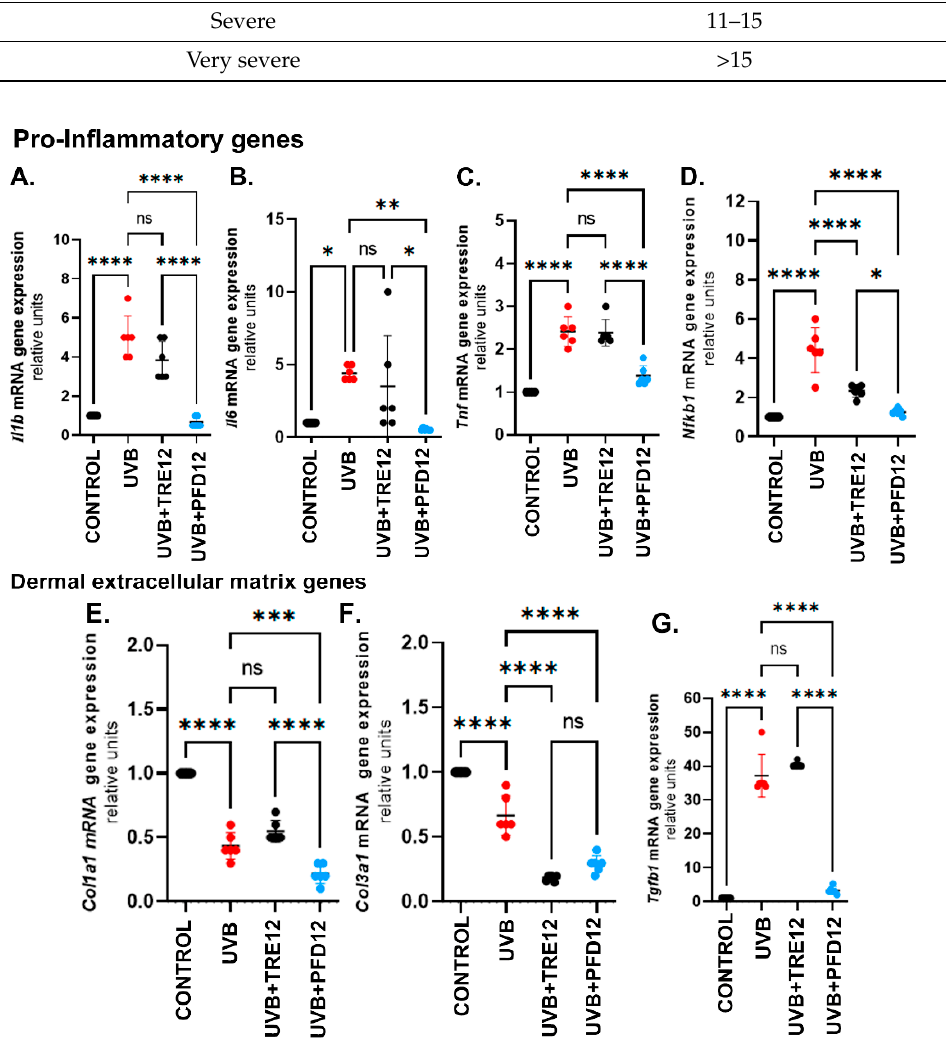
Figure 4. Gene expression of molecules implicated in photodamage. Pro-inflammatory cytokines ( A ) Il1b -1, ( B ) Il6 , and ( C ) Tnf decreased after PDF treatment. ( D ) Nfkb1 and ( E ) Col1a1 were down- regulated by PFD. ( F ) Col3a1 mRNA levels are downregulated in UVB + TRE12 and UVB + PDF